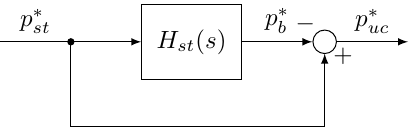
Figure 8. Calculation of the power references for the batteries p ∗